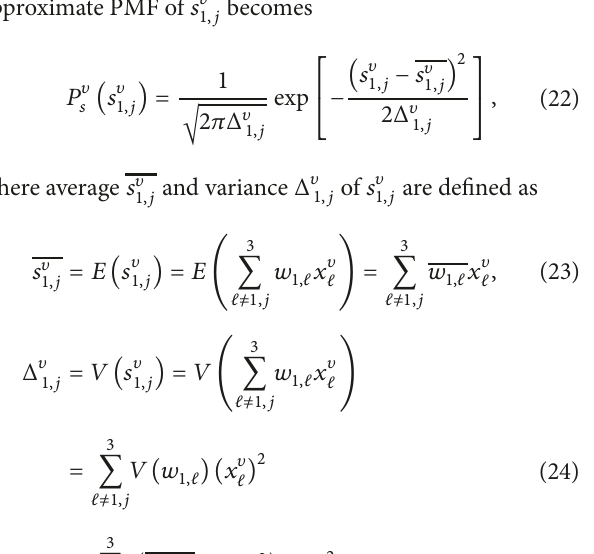
for some positive integer 𝑚 , message 𝜌 𝑚 𝜌 𝜐 (𝑤 ) = 1,𝑗